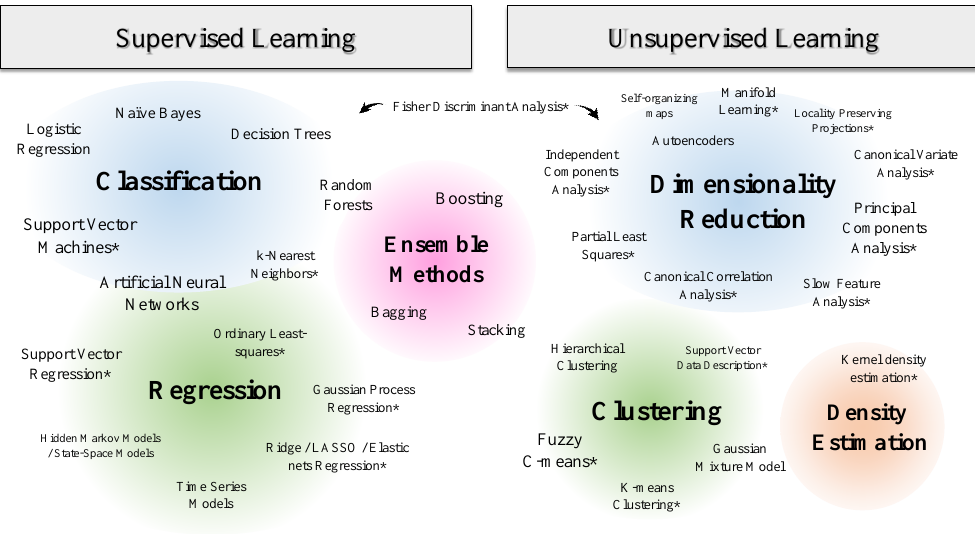
Figure 4. Machine learning methods relevant to process monitoring (from the authors’ perspective). Those with (*) have versions that belong to the family of kernel